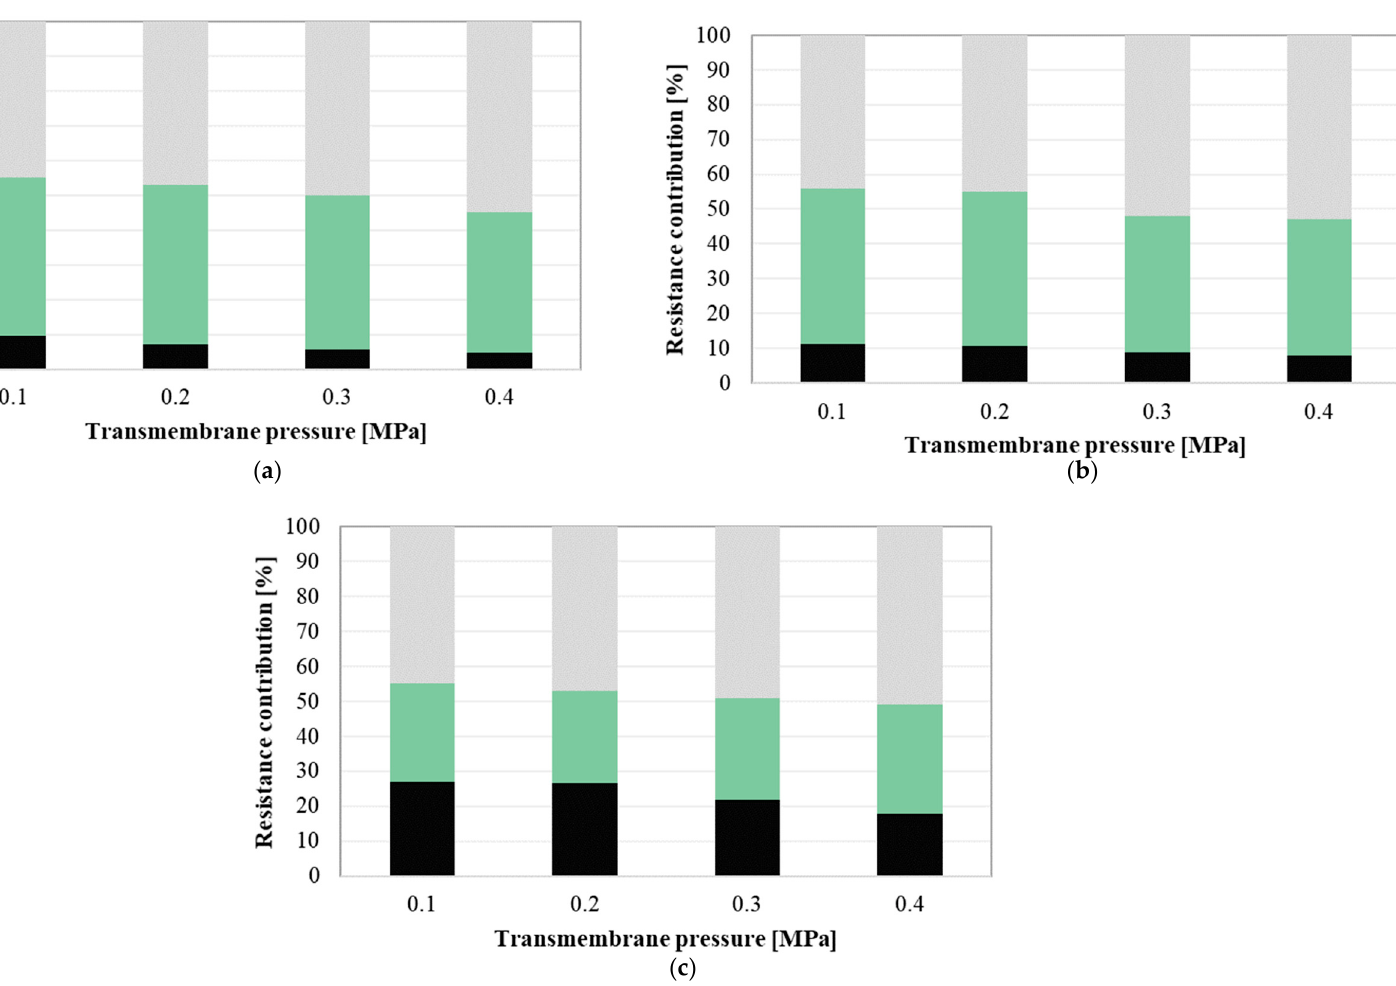
/ h): ( a ) 200, ( b ) 300, ( c ) Q = 400 irreversible fouling, reversible fouling,